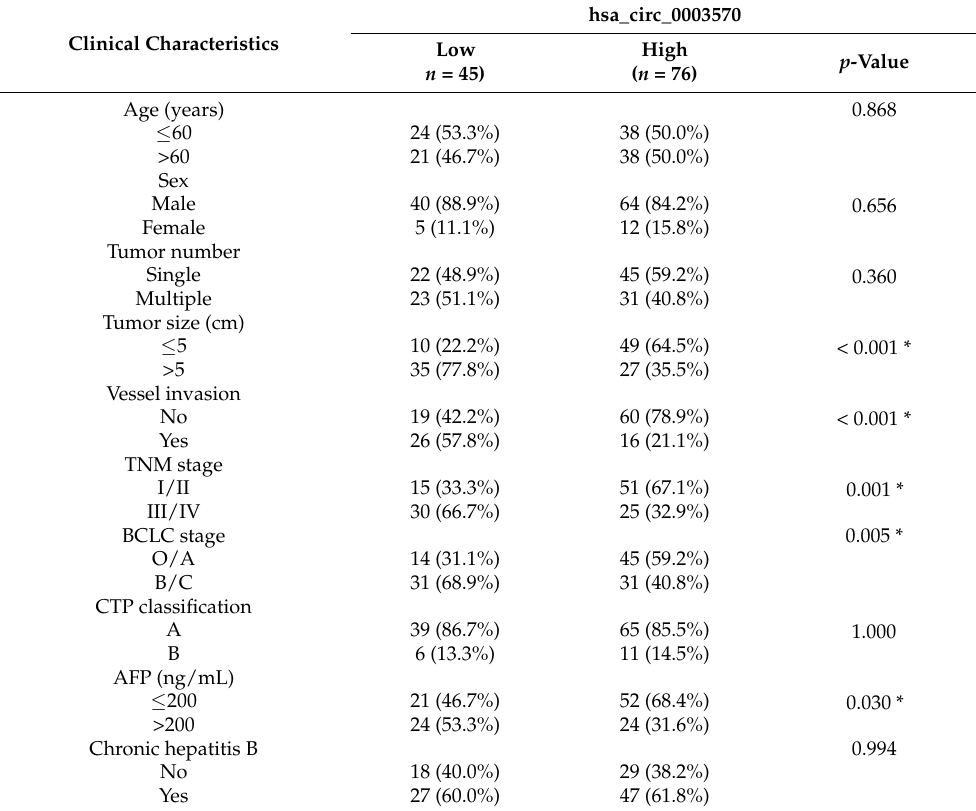
Table 2. Clinical characteristics of patients according to hsa_circ_0003570 expression.